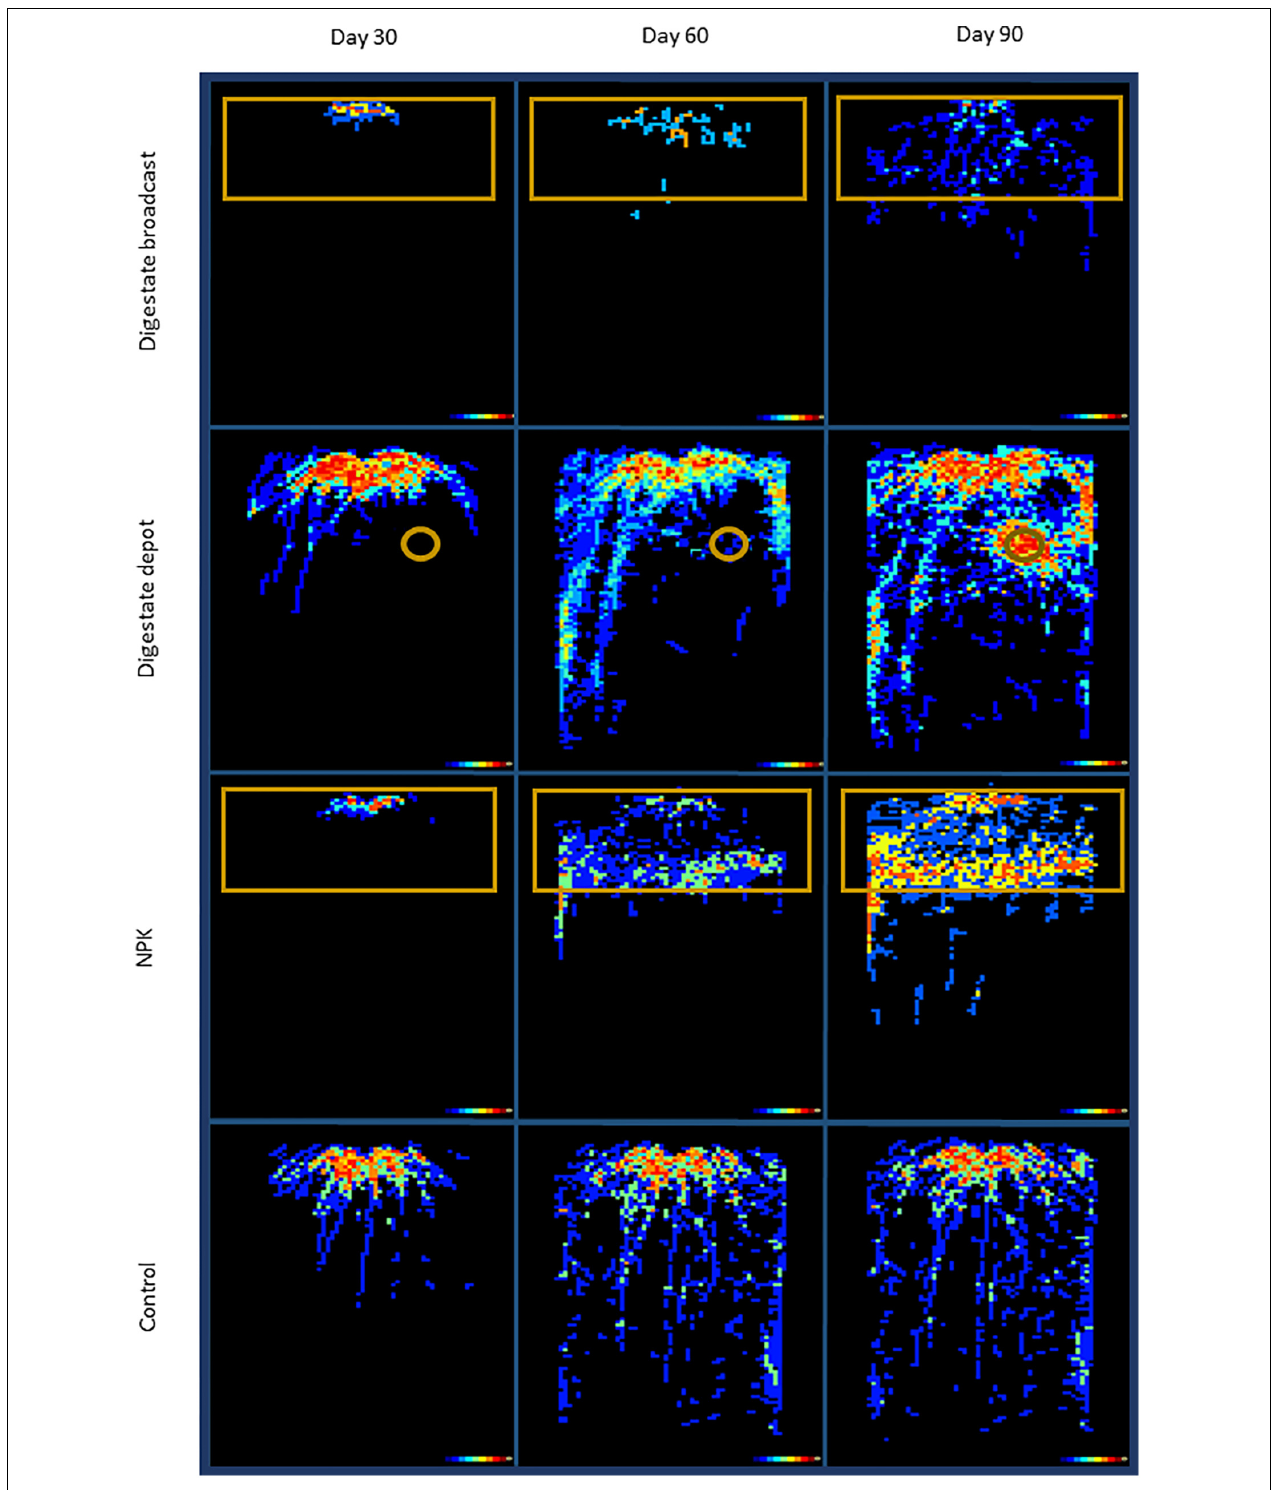
FIGURE 2 | Hit-Map of rhizotrons. In digestate depot fertilized rhizotrons roots of S. hermaphrodita avoid the digestate depot zone for 60 days but form a dense root cluster in the depot zone after 90 days. Colors indicate the number of replicates that grew roots at the specific pixel (black: none; blue: 1–2; green 3–4; orange 5–6; red 7–8 replicates). Orange frames illustrate the fertilized zones of the rhizotrons. All fertilization treatments were adjusted to a digestate application of 40 t ha − 1 : Control: no fertilization; Digestate broadcast: homogeneously incorporated in the top 20 cm; Digestate depot: localized digestate application; NPK homogeneously incorporated in the top 20 cm; n = 8 replicates for each treatment and time of